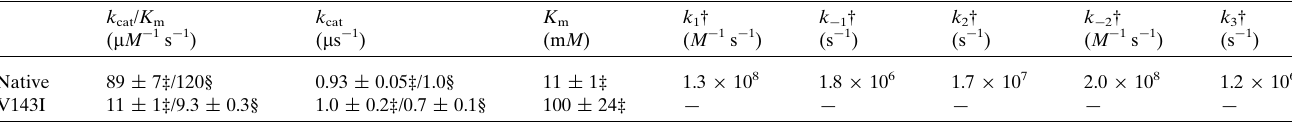
Table 1 Steady-state kinetic parameters for CO 2 hydration by native and V143I CA II. k cat / K m ( m M (cid:2) 1 s (cid:2) 1